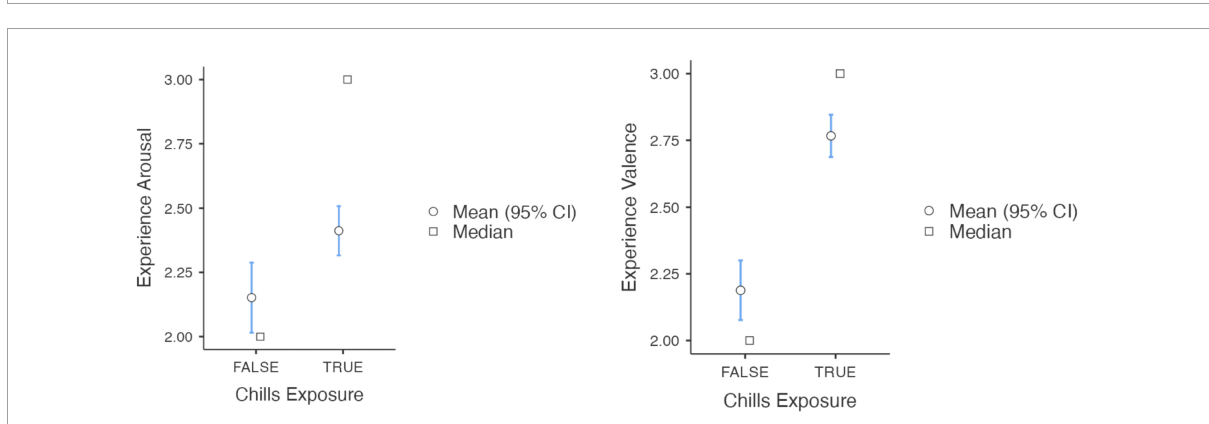
FIGURE2 Participants rating of the experience depending on whether they experienced chills or not. We found that participants who experienced chills report significantly greater valence and arousal than those who did not.